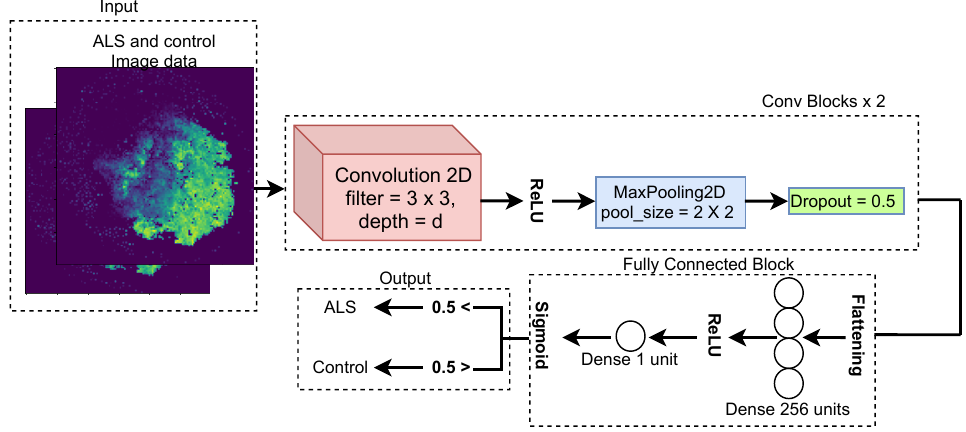
Figure 3. CNN architecture for classifying ALS and control